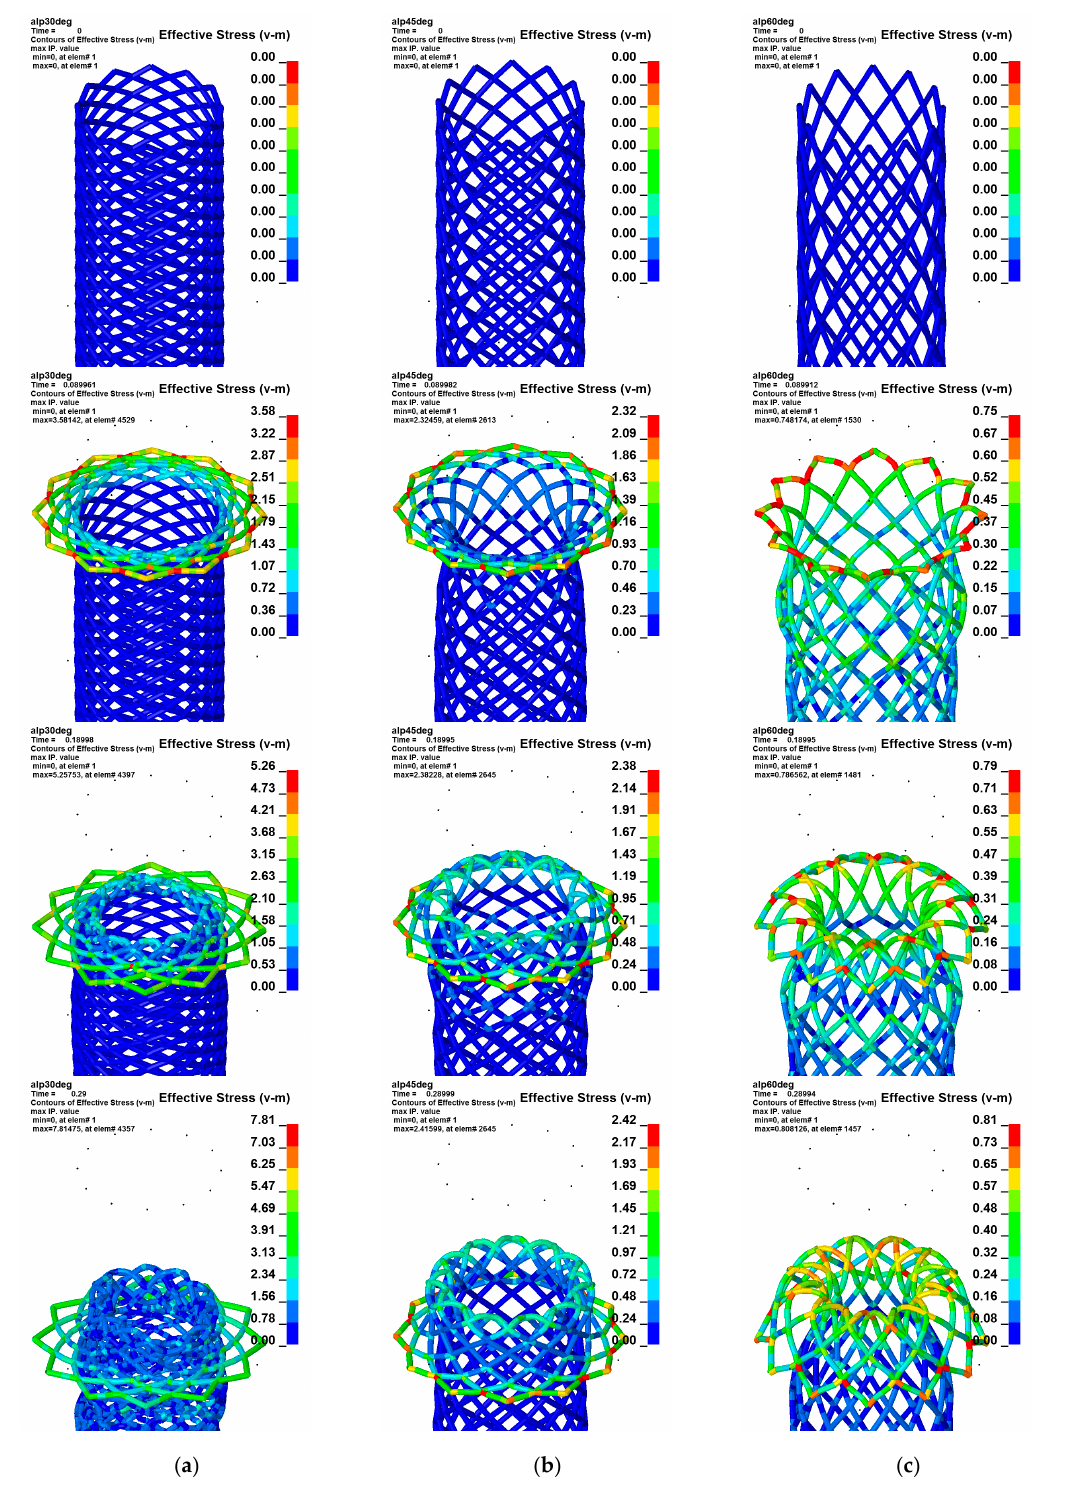
Figure 10. Equivalent von Mises beam stress distribution in everting simulation: net angle 30° ( a ), net angle 45° ( b ) and net angle 60° ( c ). Different stages of the everting process are shown from top to bottom for each net angle (columns) at equal times (rows).